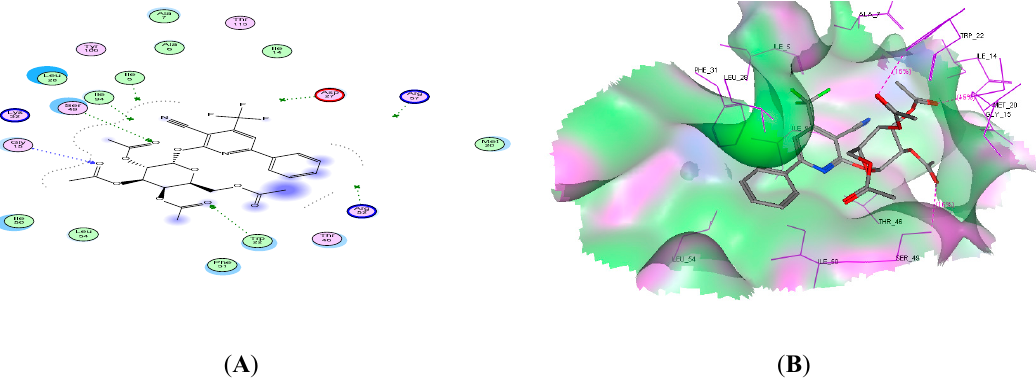
Figure 4. ( A ) 2D interactions of compound 11 c with the DHFR binding site. ( B ) 3D interactions of compound 11 c with the DHFR binding site.